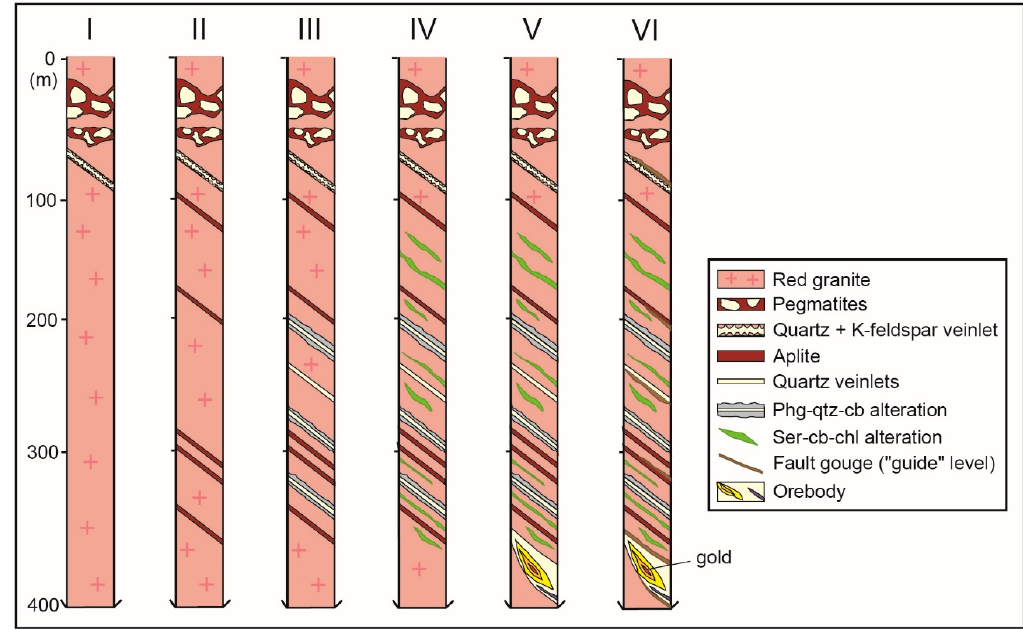
Figure 20. Schematic diagram of drill holes showing the evolutionary model of formation and distribution of the main alteration zones and mineralised veins. Different stages represent chronological order of events. Abbreviations: Cb—carbonate; Chl—chlorite; Phg—phengite; Qtz—quartz; Ser—sericite.